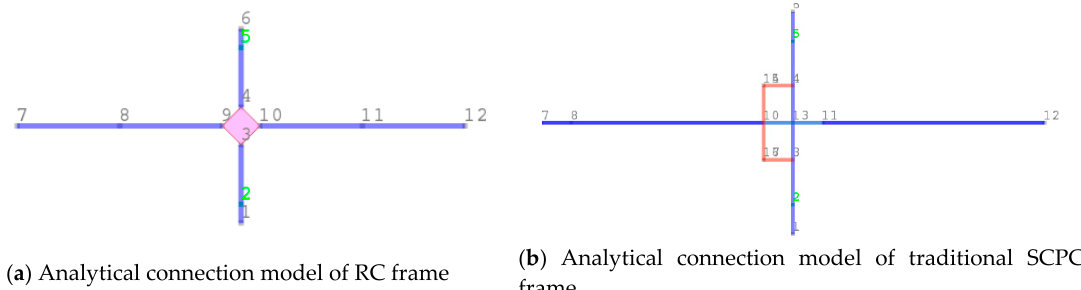
Figure 23. Analytical connection model of RC frame and traditional SCPC frame.